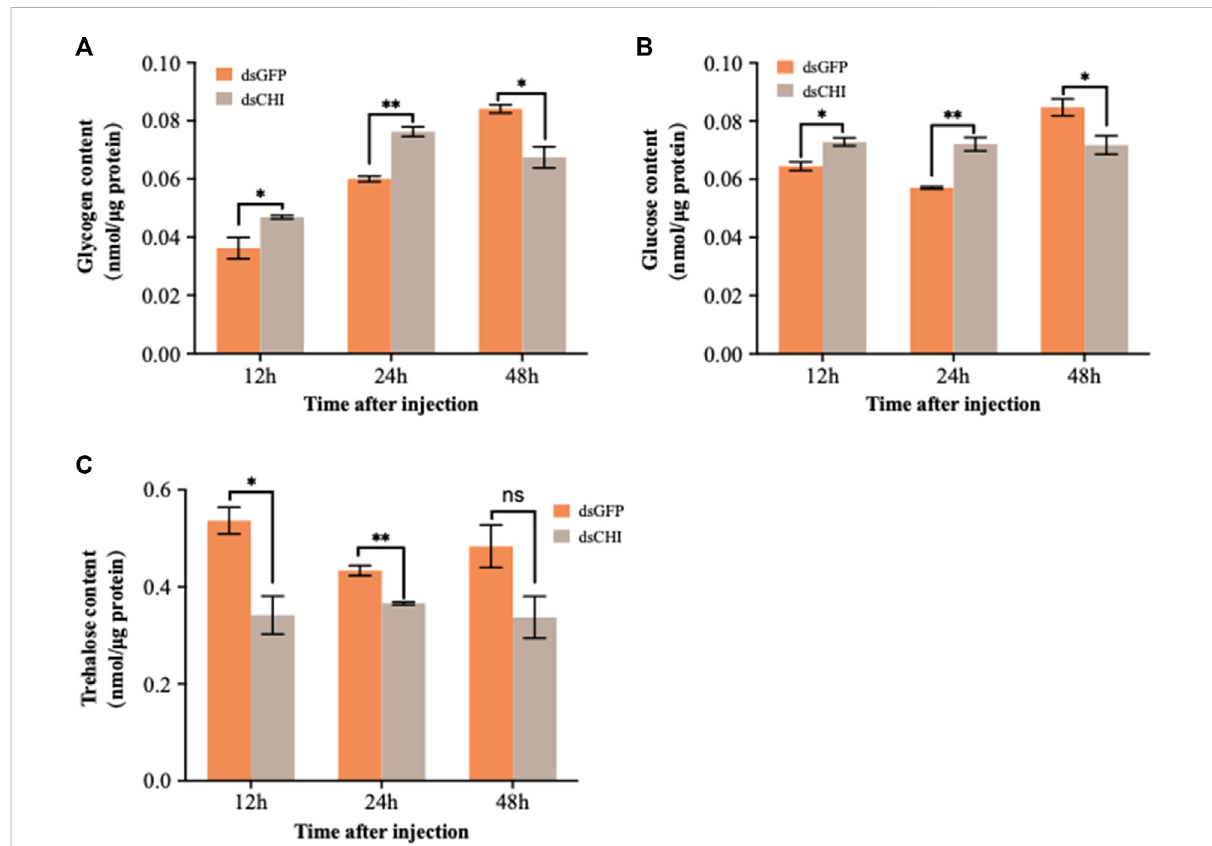
Changes in carbohydrates after RNAi. Spodoptera frugiperda larvae at the fi rst day of the third instar stage were divided into three groups and injected with dsGFP and dsCHI, respectively. Insects were collected and used to determine glycogen content (A) , glucose content (B) and trehalose content (C) at 12, 24 and 48 h after dsRNA injection. Three replicates were performed per group. (Mean ± SE; t - test; ** p < 0.01, * p < 0.05, ns p >